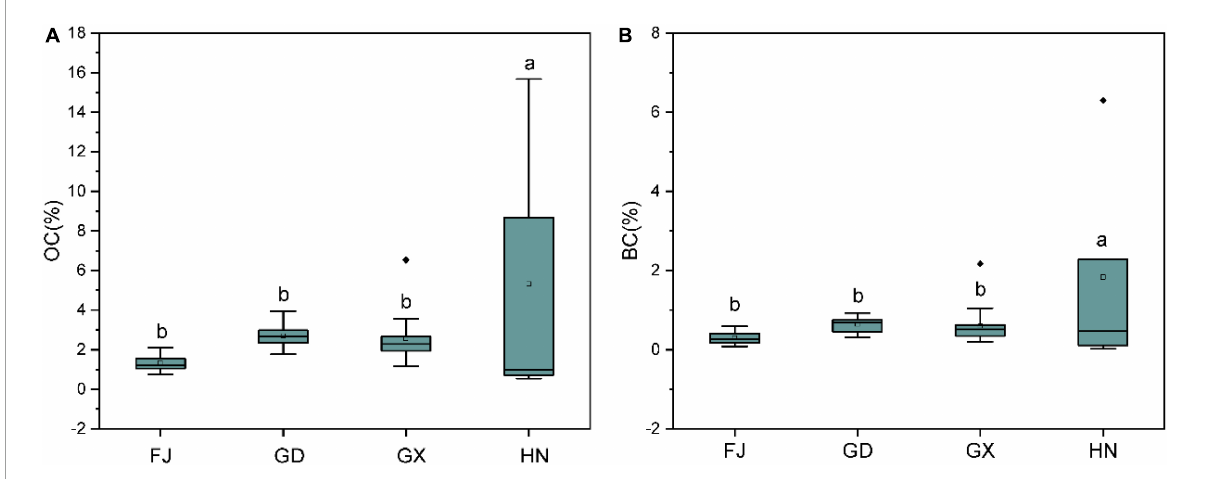
FIGURE2 Boxplots showing the organic carbon (OC; A ) and black carbon (BC; B ) content of sediments from different mangrove wetlands in China. FJ, Fujian; GD, Guangdong; GX, Guangxi; HN, Hainan. Different lowercase letters indicate significant differences ( α = 0.05).